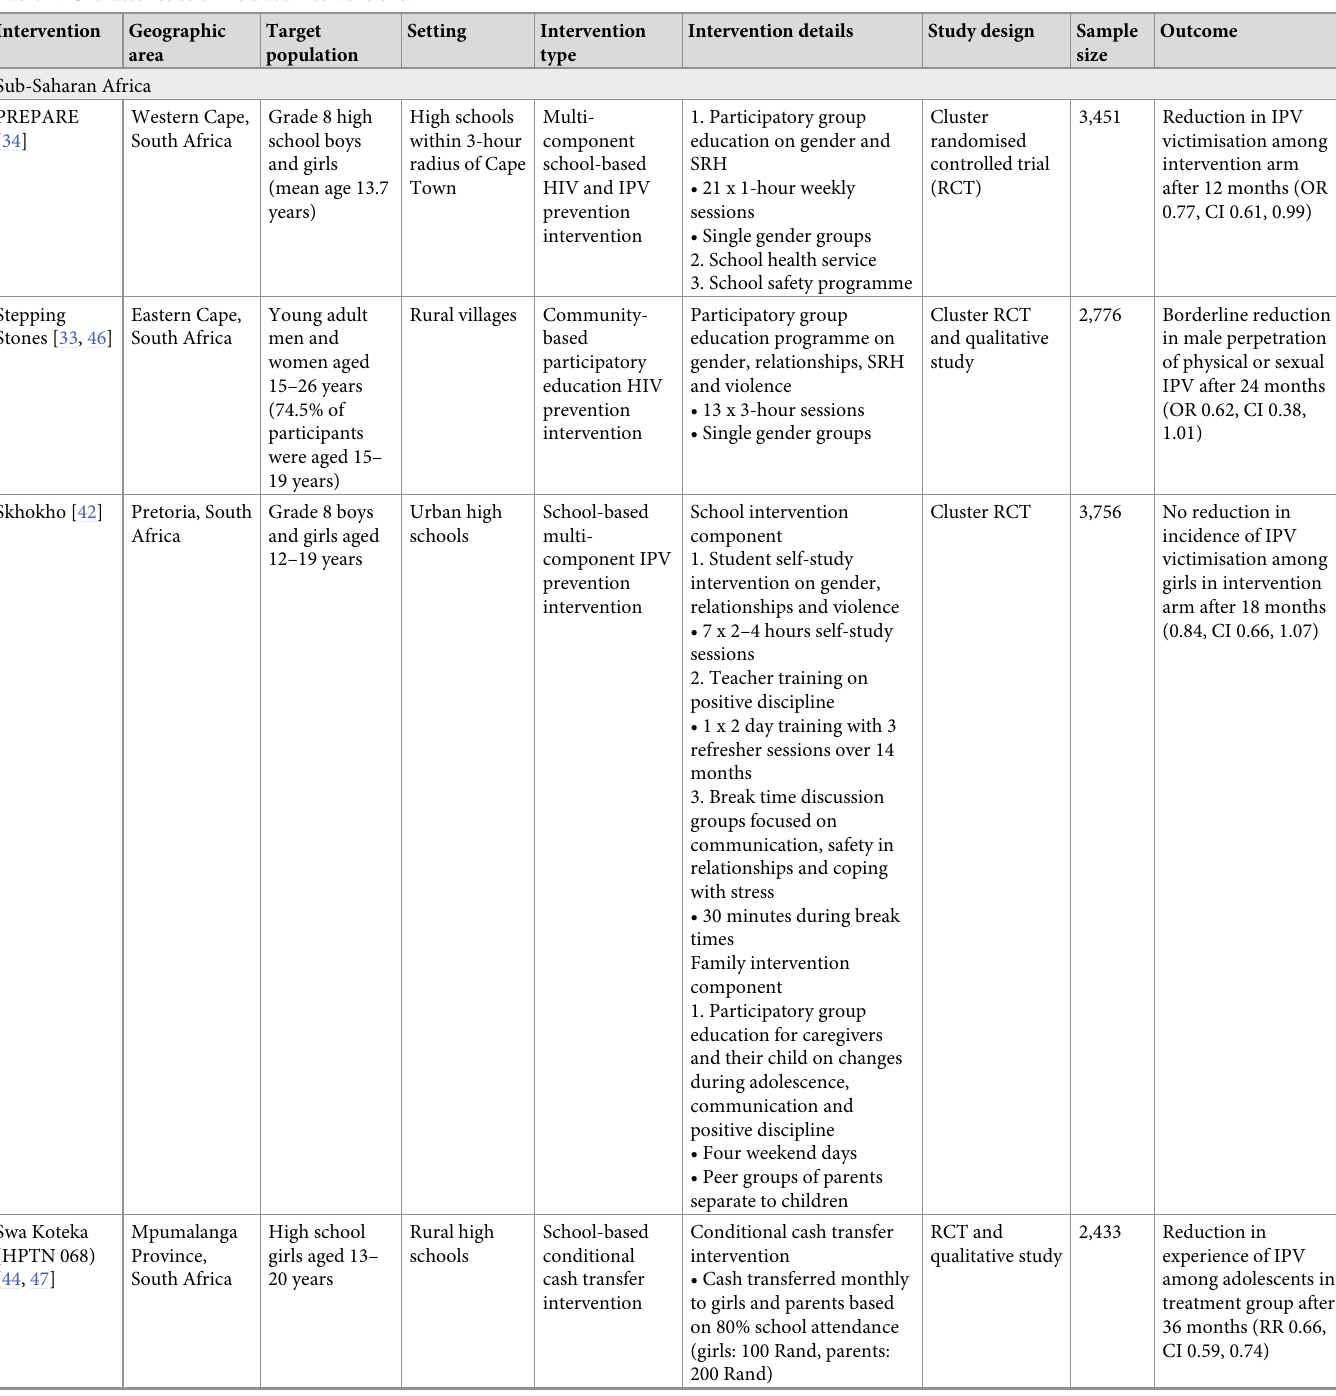
Table 1. Characteristics of included